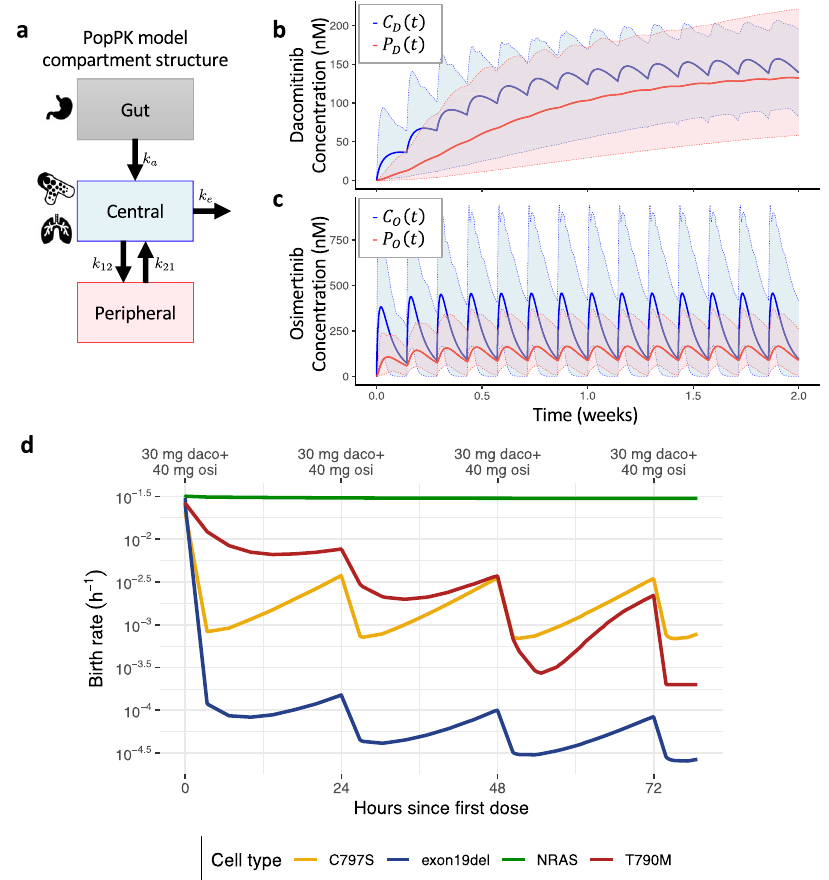
Fig. 2 Drug pharmacokinetics with inter-subject variability and effects on tumor cell fi tness. a Schematic of a two-compartment model of drug concentration over time throughout the body. Output concentrations in nanomolars from a simulation of 30 mg QD of dacomitinib ( b ) and 40 mg QD of osimertinib ( c ) in 1000 patients. Blue and red lines correspond to drug concentration in the central ( C D ð t Þ and C O ð t Þ ), and peripheral, ( P D ð t Þ and P D ð t Þ ), compartment, respectively. Solid lines are median concentrations and shaded areas represent a 95% con fi dence interval. d Birth rates of four cell types during dosing with 30 mg QD dacomitinib and 40 mg QD osimertinib in one simulated individual. Doses are given every 24 h starting at hour